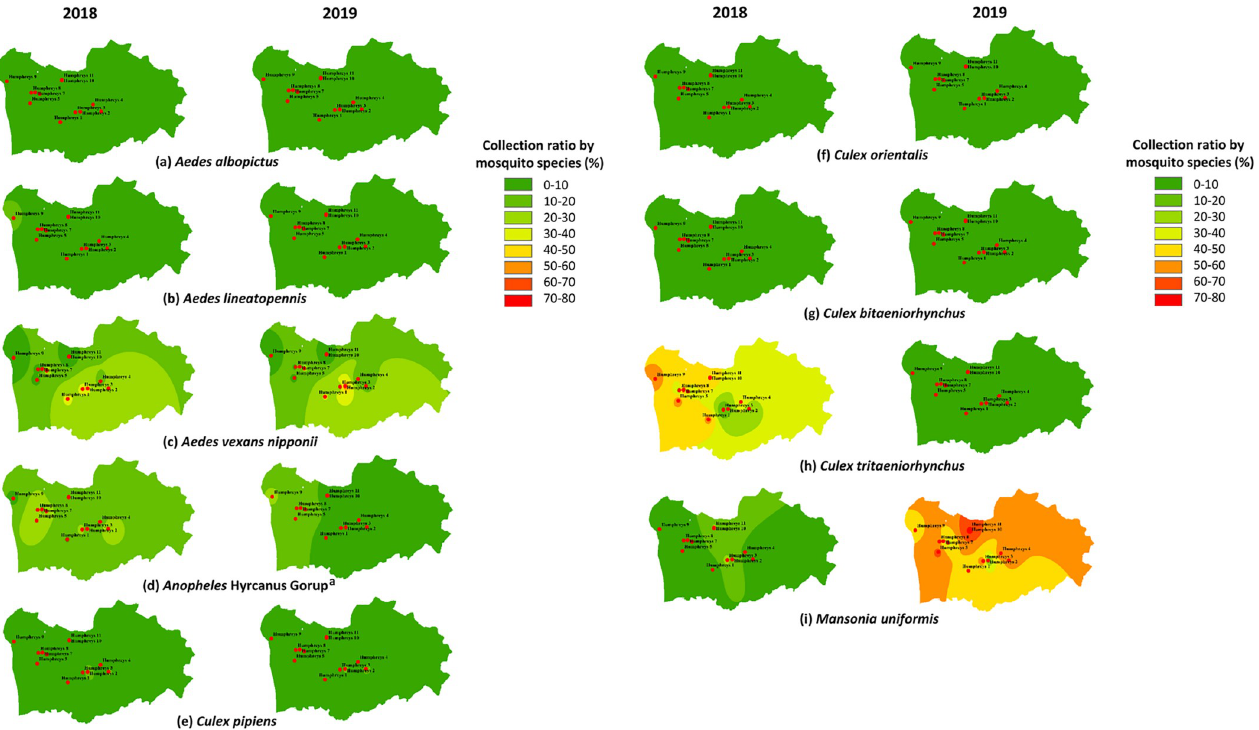
Fig 2. Geographical distribution of mean numbers of mosquitoes collected for selected species at USAG Humphreys, Pyeongtaek, Republic of Korea using Mosquito Magnet 1 traps during 2018 and 2019. � Ratio was calculated as the number of mosquitoes collected by species/the number of total mosquitoes. a Anopheles Hyrcanus Group includes An . sinensis s.s., An . belenrae , An . lesteri , An . kleini , and An . pullus that cannot be identified by morphological techniques.